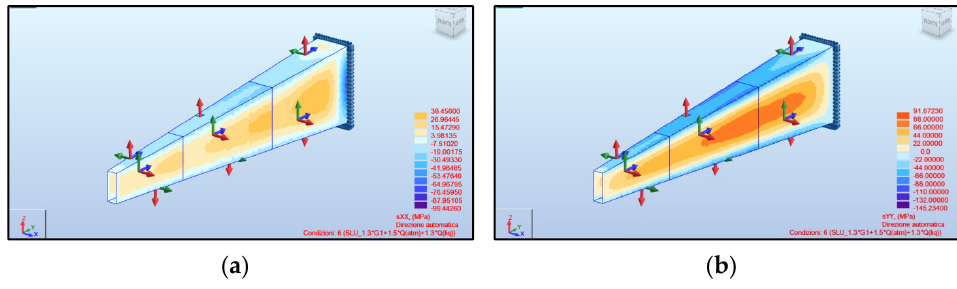
Figure 10. Internal steel sheet stress path: ( a ) UC σ x; ( b ) UC σ y.